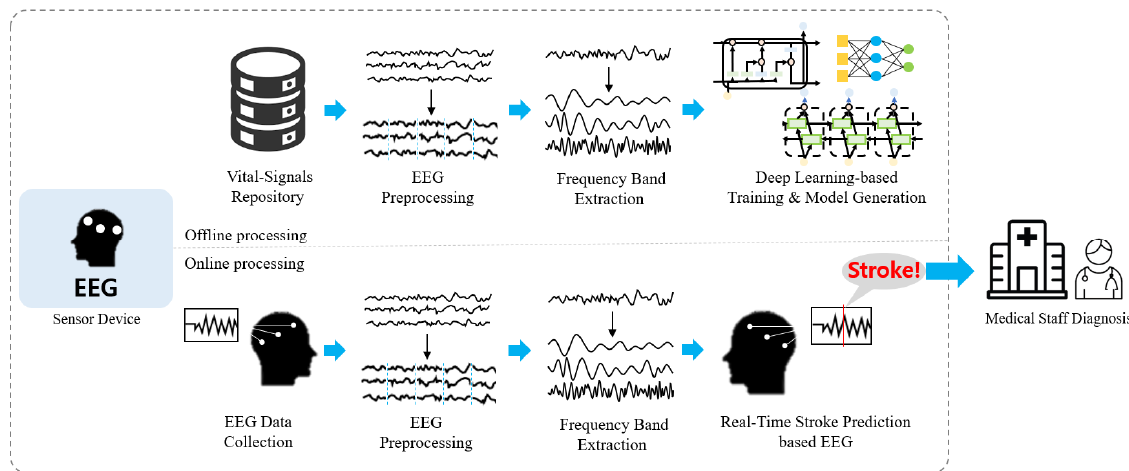
Figure 4. Stroke prediction module structure based on deep learning .